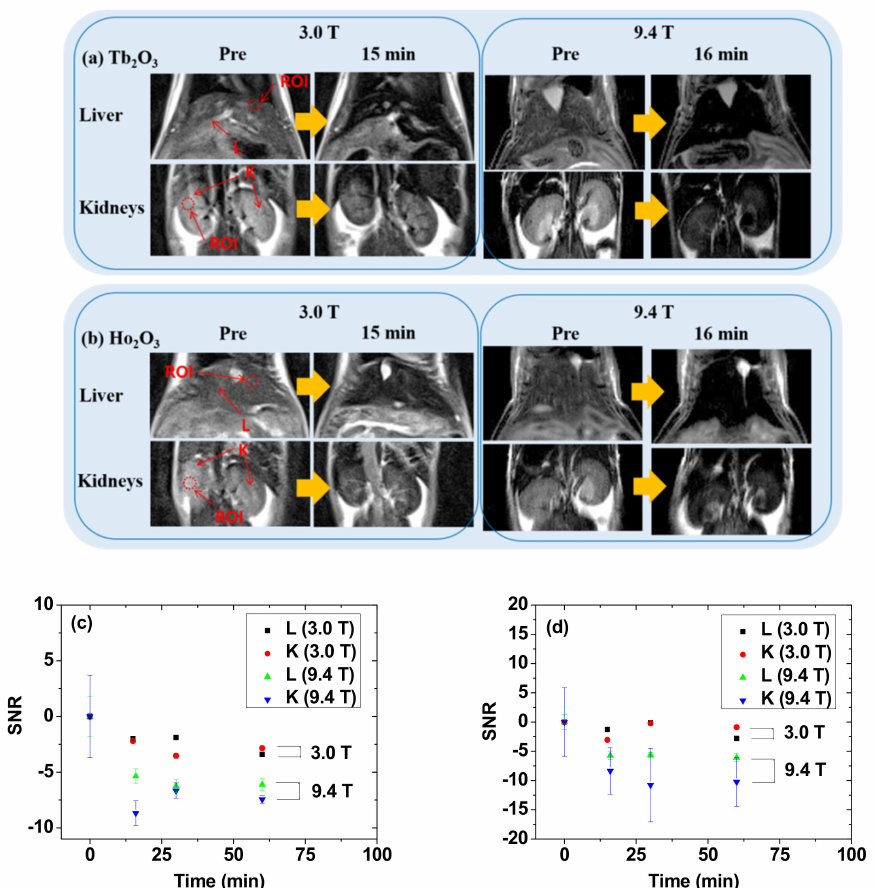
Figure 8. In vivo T 2 MR images of the liver and kidneys at 3.0 and 9.4 T MR fields before (=Pre) and 15 (or 16) min after intravenous administration of aqueous suspension samples of the PAA-coated Ln 2 O 3 NPs into mice tails [Ln = ( a ) Tb and ( b ) Ho]. SNR plots of ROI as a function of time (0 = Pre) at 3.0 and 9.4 T MR fields for the PAA-coated Ln 2 O 3 NPs [Ln = ( c ) Tb and ( d ) Ho]. Labels at each first MR image on the left: ROI = small dotted circles; L = liver; K =